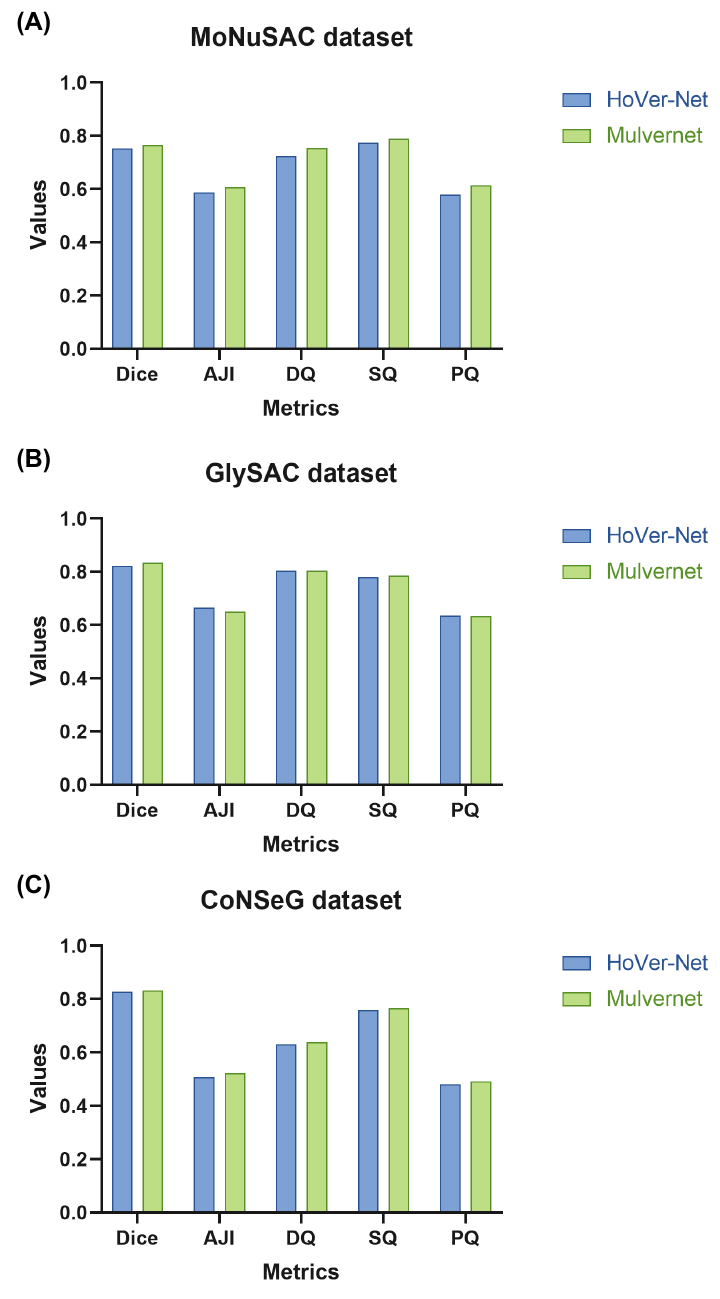
Figure 5. The comparison of five evaluation metrics in three datasets between original HoVer-Net and Mulvernet. ( A ) The comparison on MoNuSAC dataset. ( B ) The comparison on GlySAC dataset. ( C ) The comparison on CoNSeP